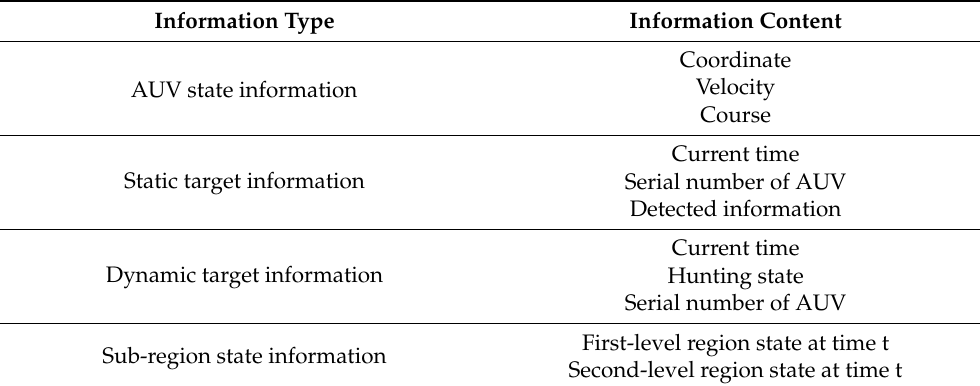
Table 1. Communication in multi-AUV